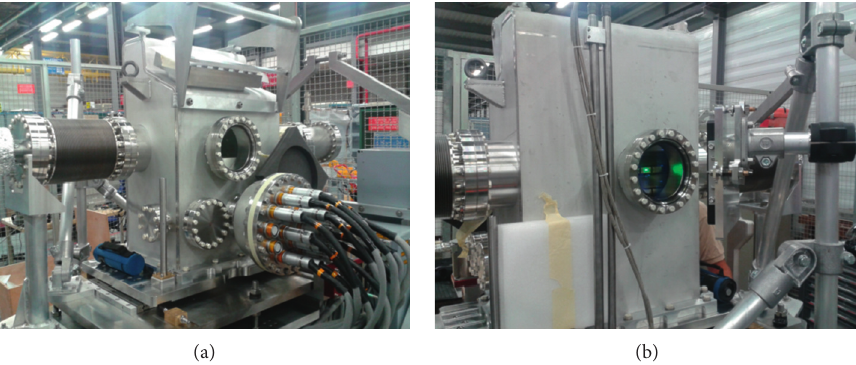
Figure 7: Assembled vacuum tank with DAQ cables and connectors (a); viewport for LDV measurements (b) [15].